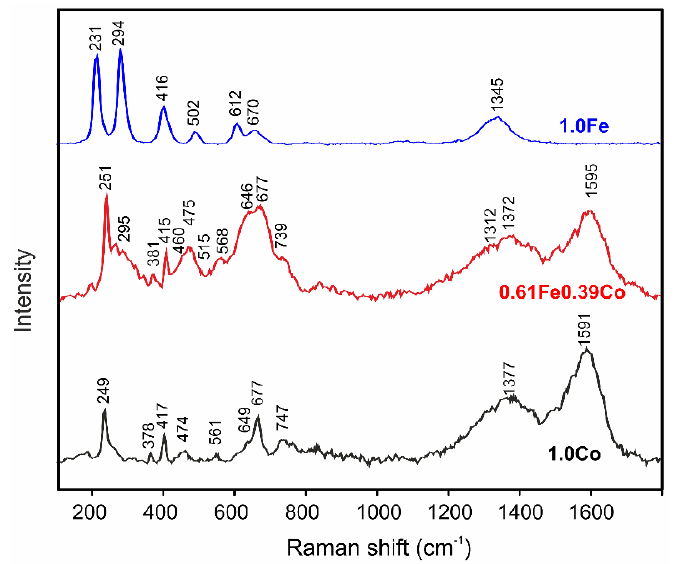
Figure 4. Raman spectra for 1.0Co (black), 1.0Fe (blue) and 0.61Fe0.39Co (red) thin films.